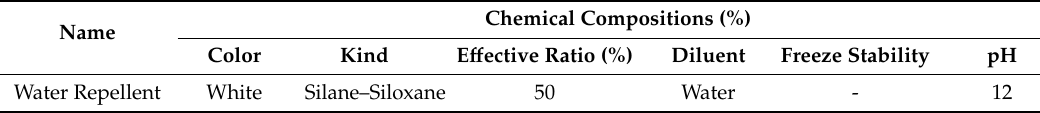
Table 5. Chemical compositions of water